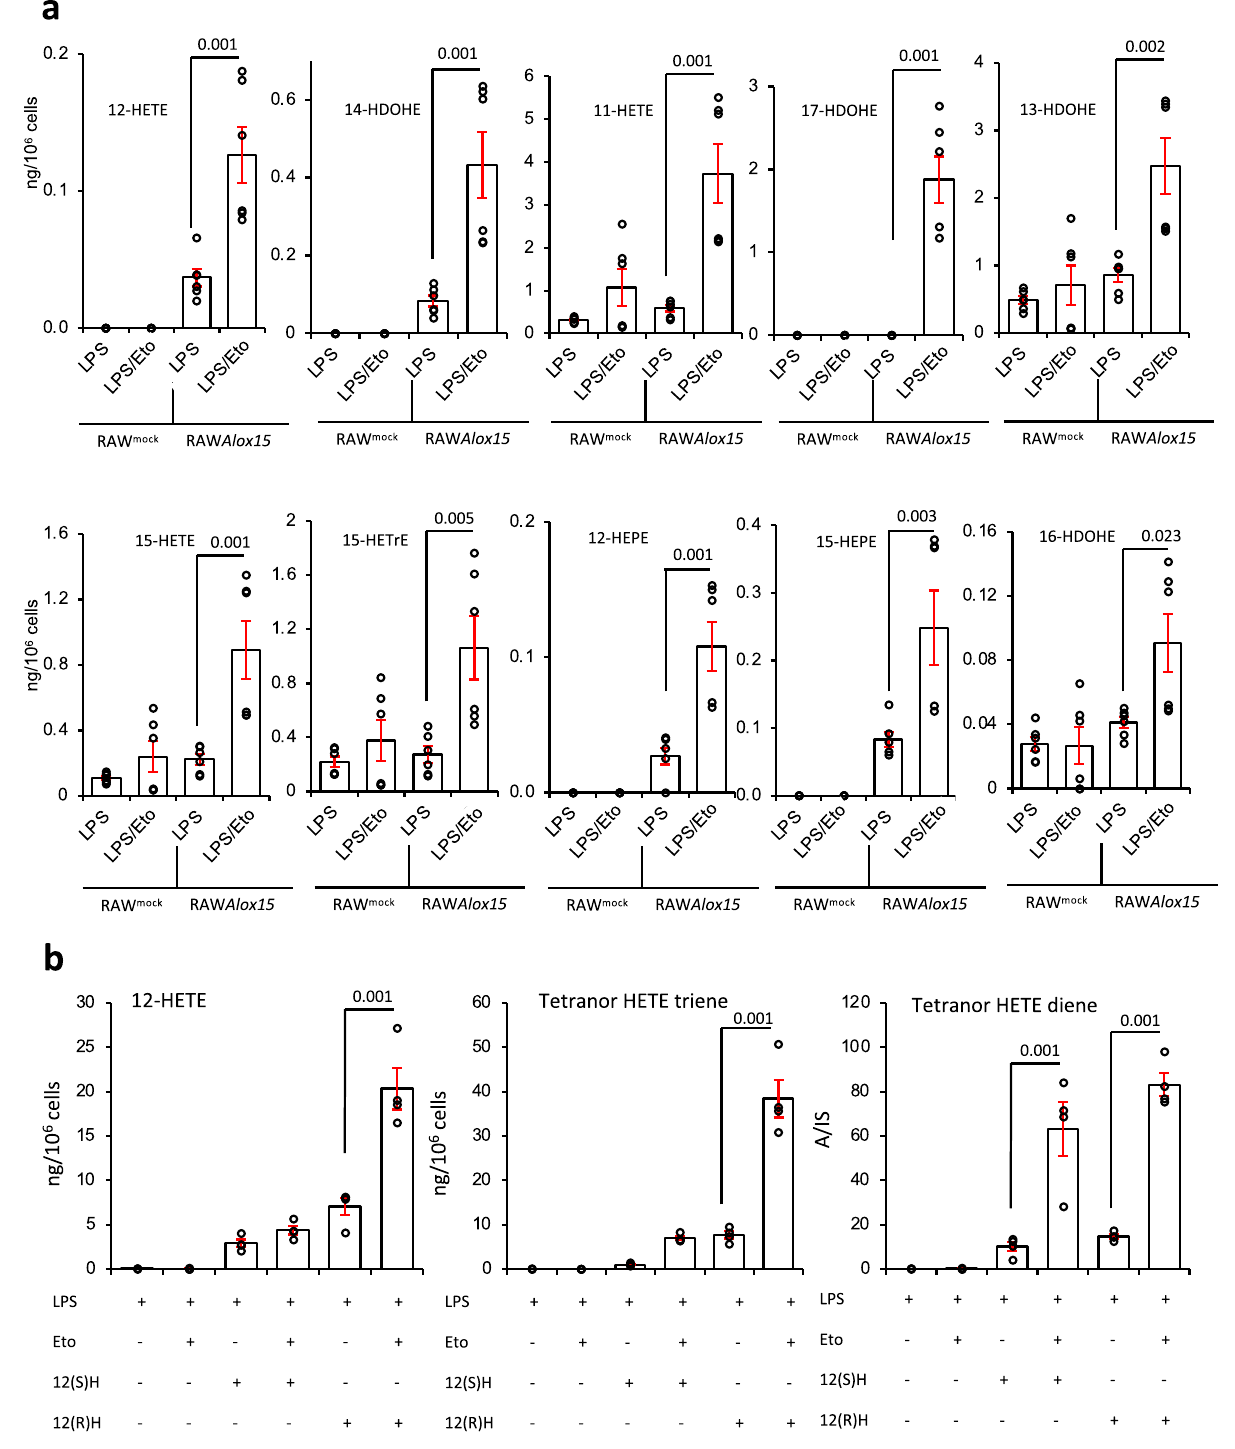
forms via saturation of the triene, con fi rming the structure as 8(S)-hydroxy-6E,10Z-hexadecadienoic acid. Next, the impact of CPT1 inhibition on the metabolism of exogenous 12(S)-HETE or 12(R)HETE was tested. Both HETEs were rapidly removed by LPS-stimulated RAW cells, with around 0.15% or 0.4% remaining after 3 h, for the S and R forms, respectively (Fig. 2b, left panel). Cellular and supernatant 12(S)-